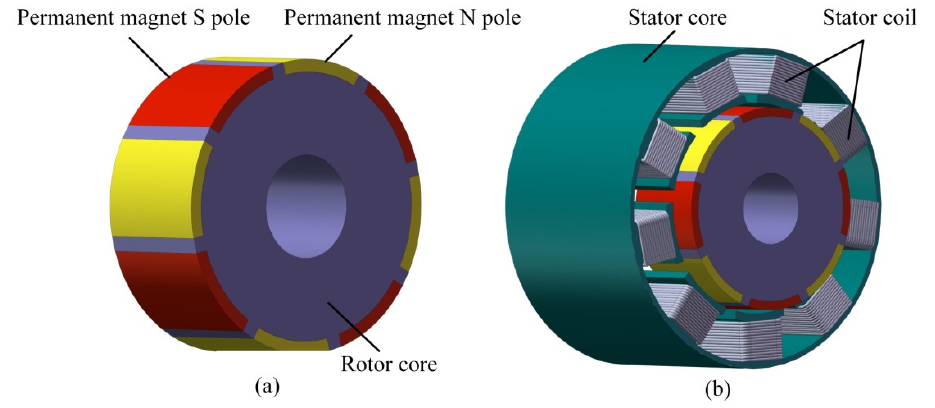
Figure 16. Structure of the EMA; ( a ) Rotor model; ( b ) Stator model.